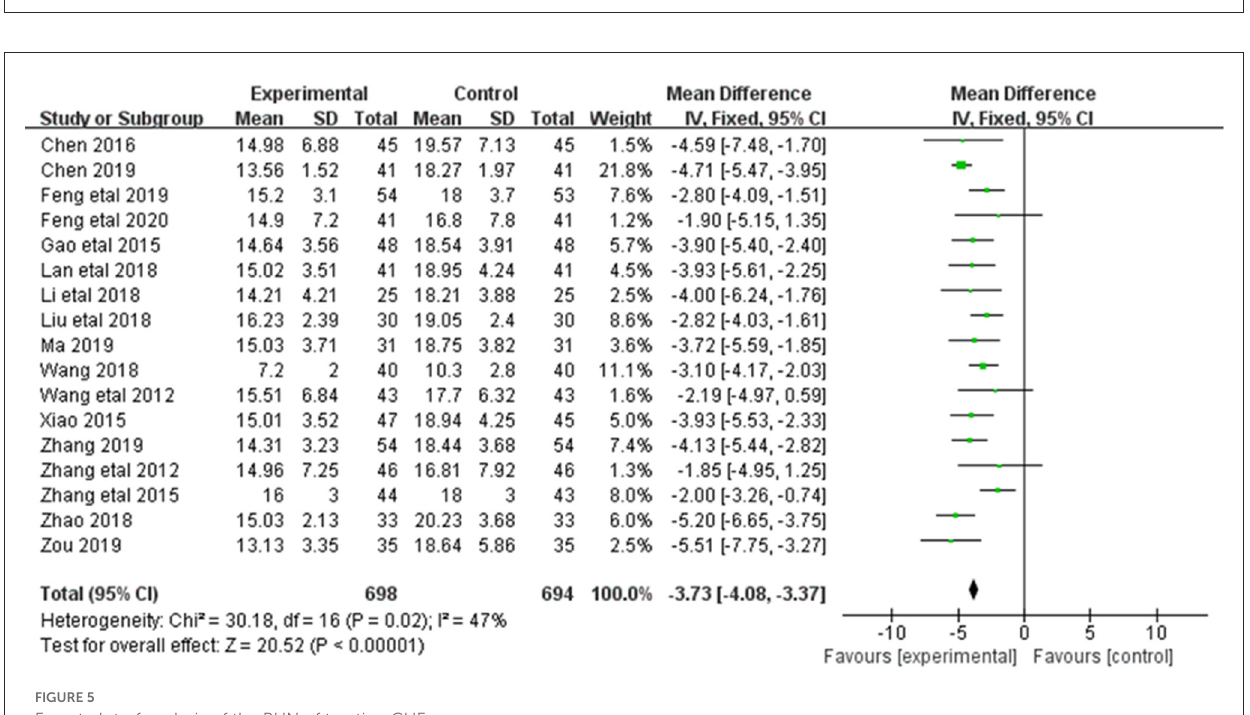
among the studies (DF=14, P = 0.14, I 2 = 29%). Therefore, the fixed effect model was used for analysis. The overall